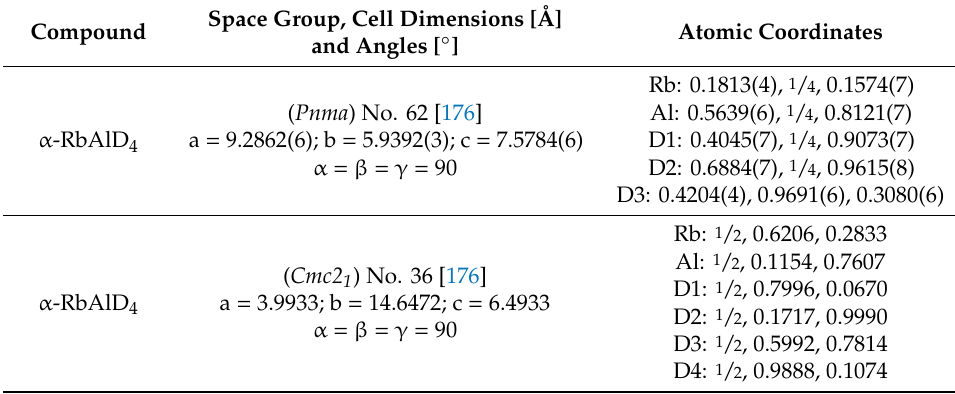
Table 5. Crystallographic data of